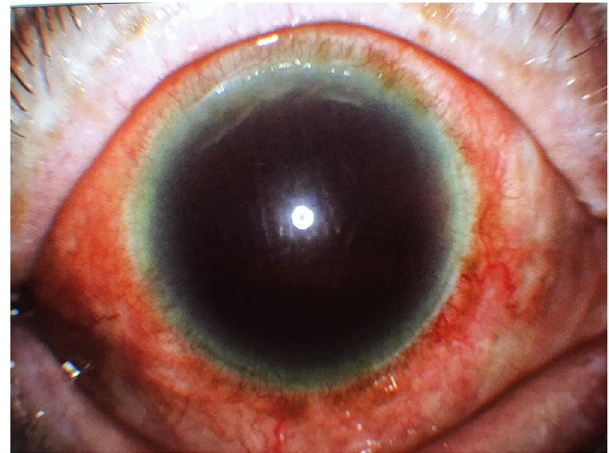
Figure 5. Hypotony with spontaneous bleeding in the anterior chamber after TCP. The eyeball is soft, and corneal folds could be seen. Furthermore, spontaneous bleeding almost filled the anterior chamber. The fundus could not be